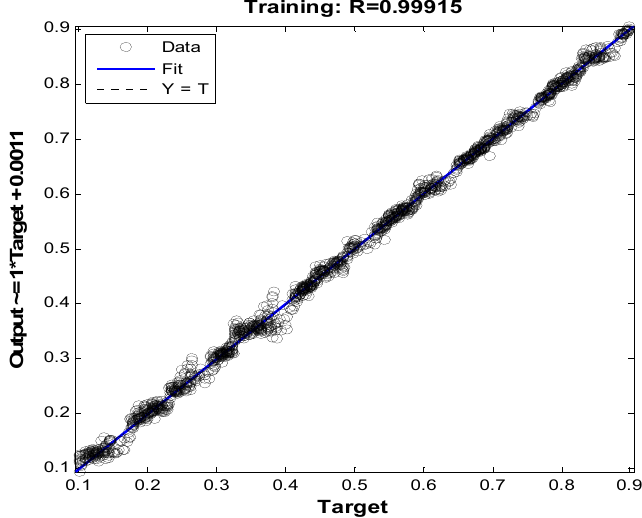
Figure 8. Error percentage obtained from estimated and actual data of SOC for PSO-ANN algorithm.